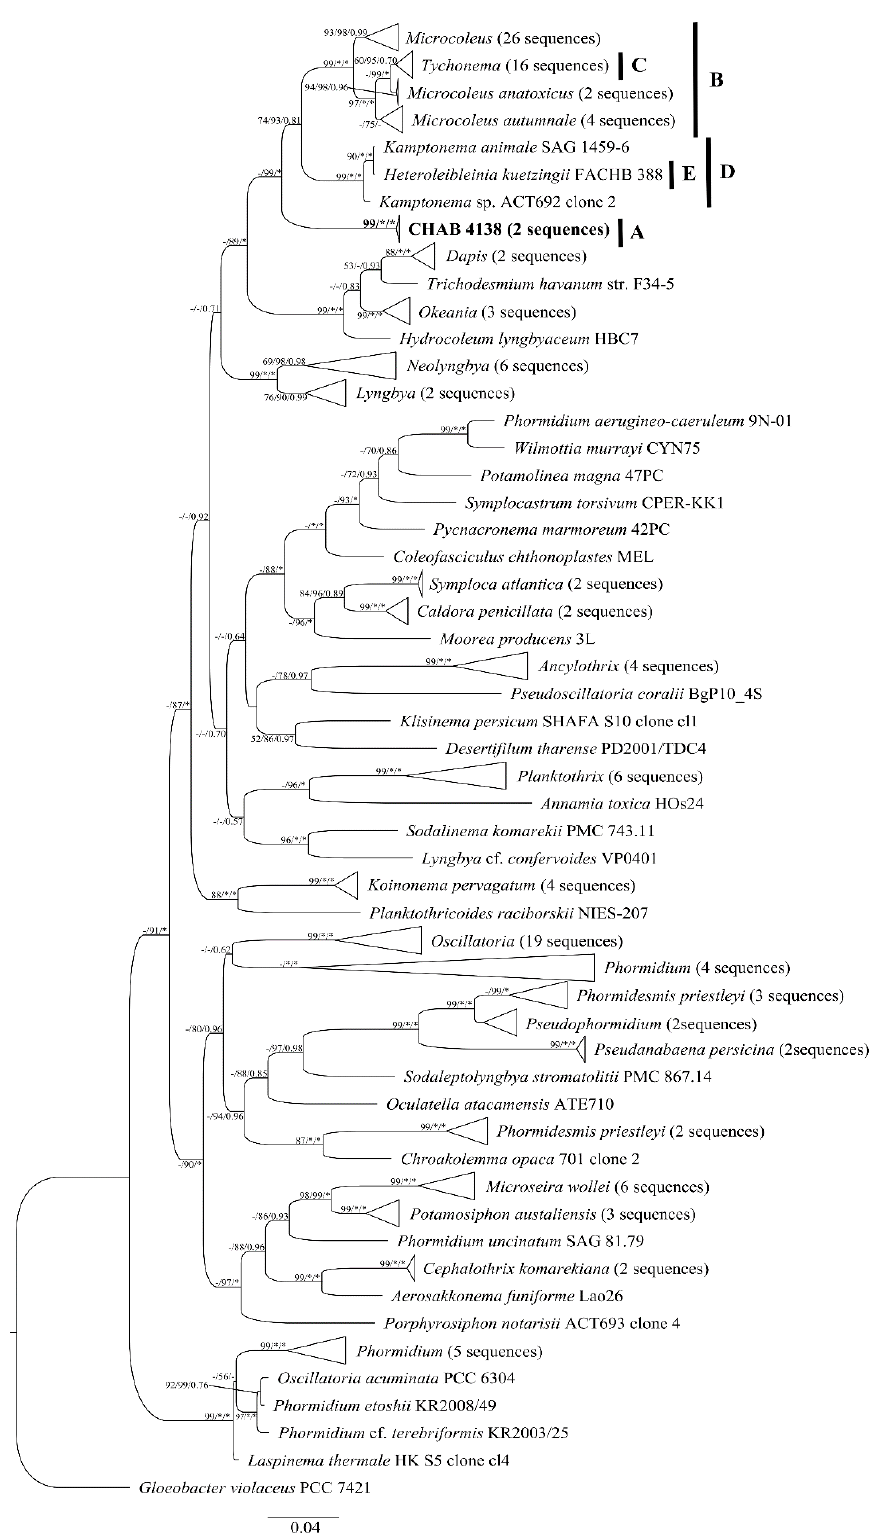
Figure 3. Bayesian inference (BI) phylogenetic tree of Microcoleusiopsis ganfuensis CHAB 4138 based on 16S rRNA gene sequences. Bootstrap values greater than 50% are showed on the BI tree for NJ/ML methods and Bayesian posterior probabilities. A – E represent Microcoleusiopsis ganfuensis strains, Microcoleus strains, Tychonema strains, Kamptonema strains and Heteroleibleinia strain, respectively. “*” indicates bootstrap values of 100 in ML and NJ and BI posterior probabilities of 1.00. The novel filamentous strains of this study indicate in bold. Bar, 0.04.